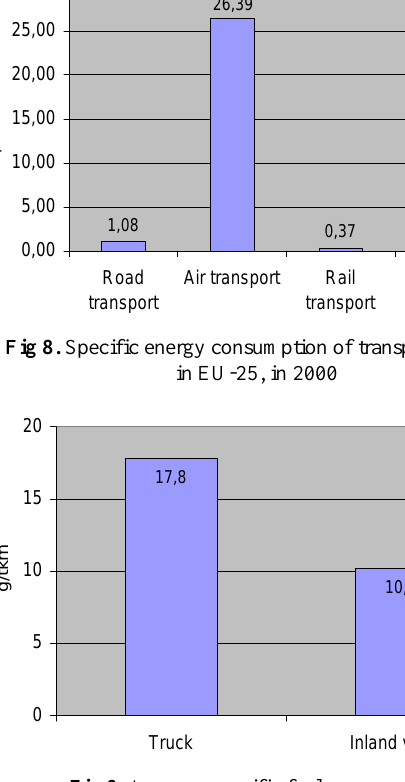
Fig 9. Average specific fuel